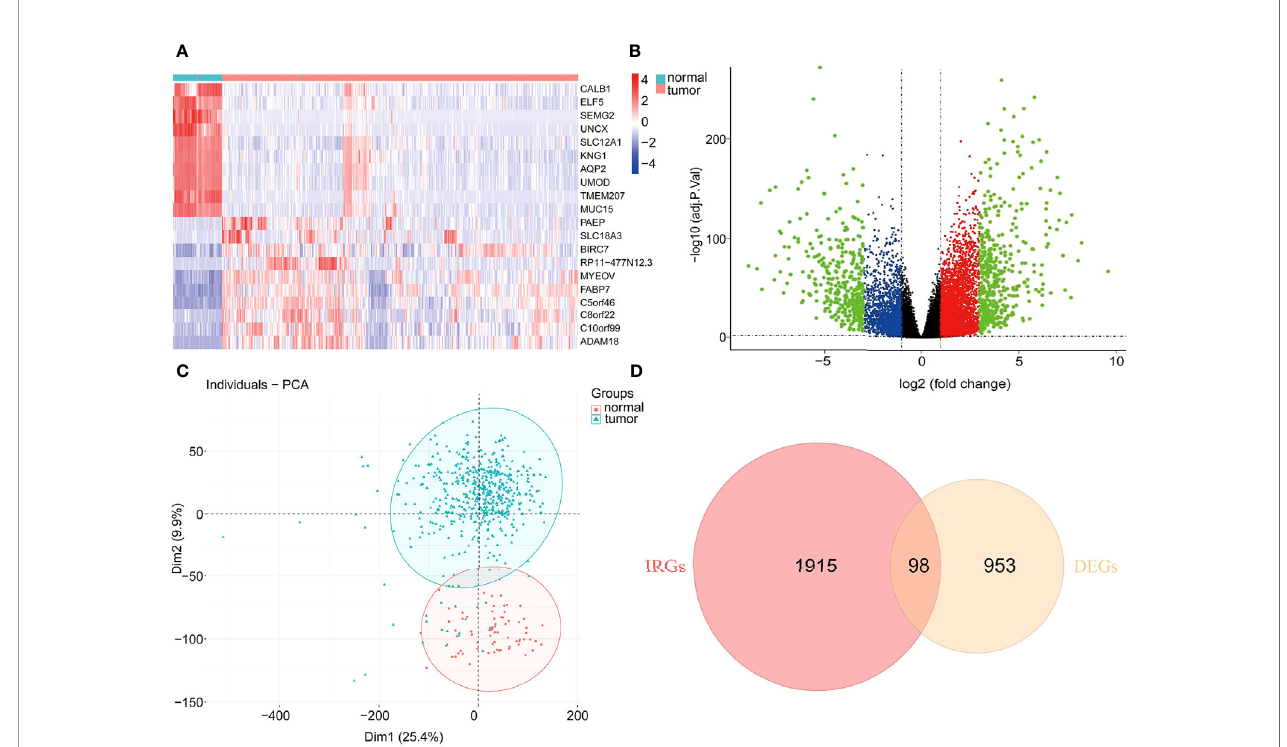
FIGURE 1 | Differentially expressed immune-associated genes. (A) Heatmap of top 10 up- and down-regulated genes between normal and tumor tissues. (B) Volcano plot for DEGs between normal and tumor tissues. (C) PCA plot of the data. (D) Venn diagram for intersections between DEGs and